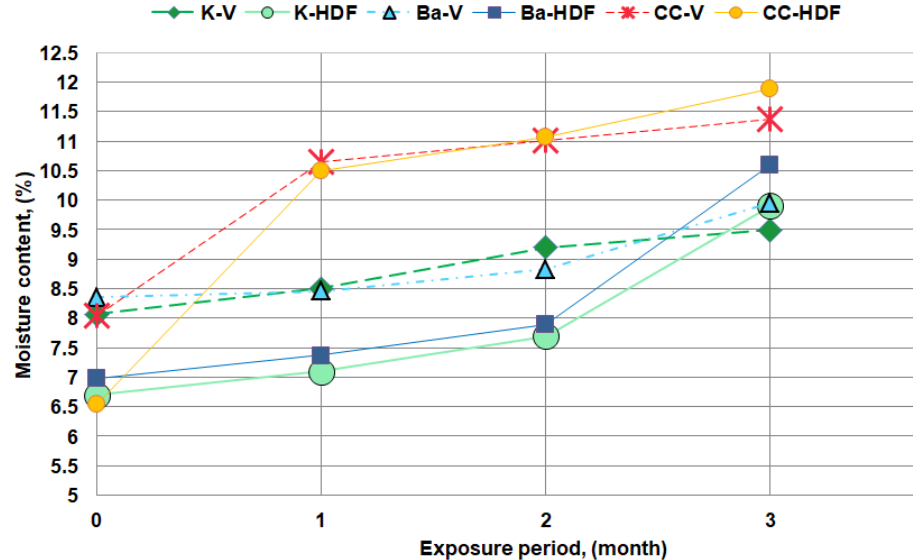
Figure 4. Variation of MC for all panels in all three situations of